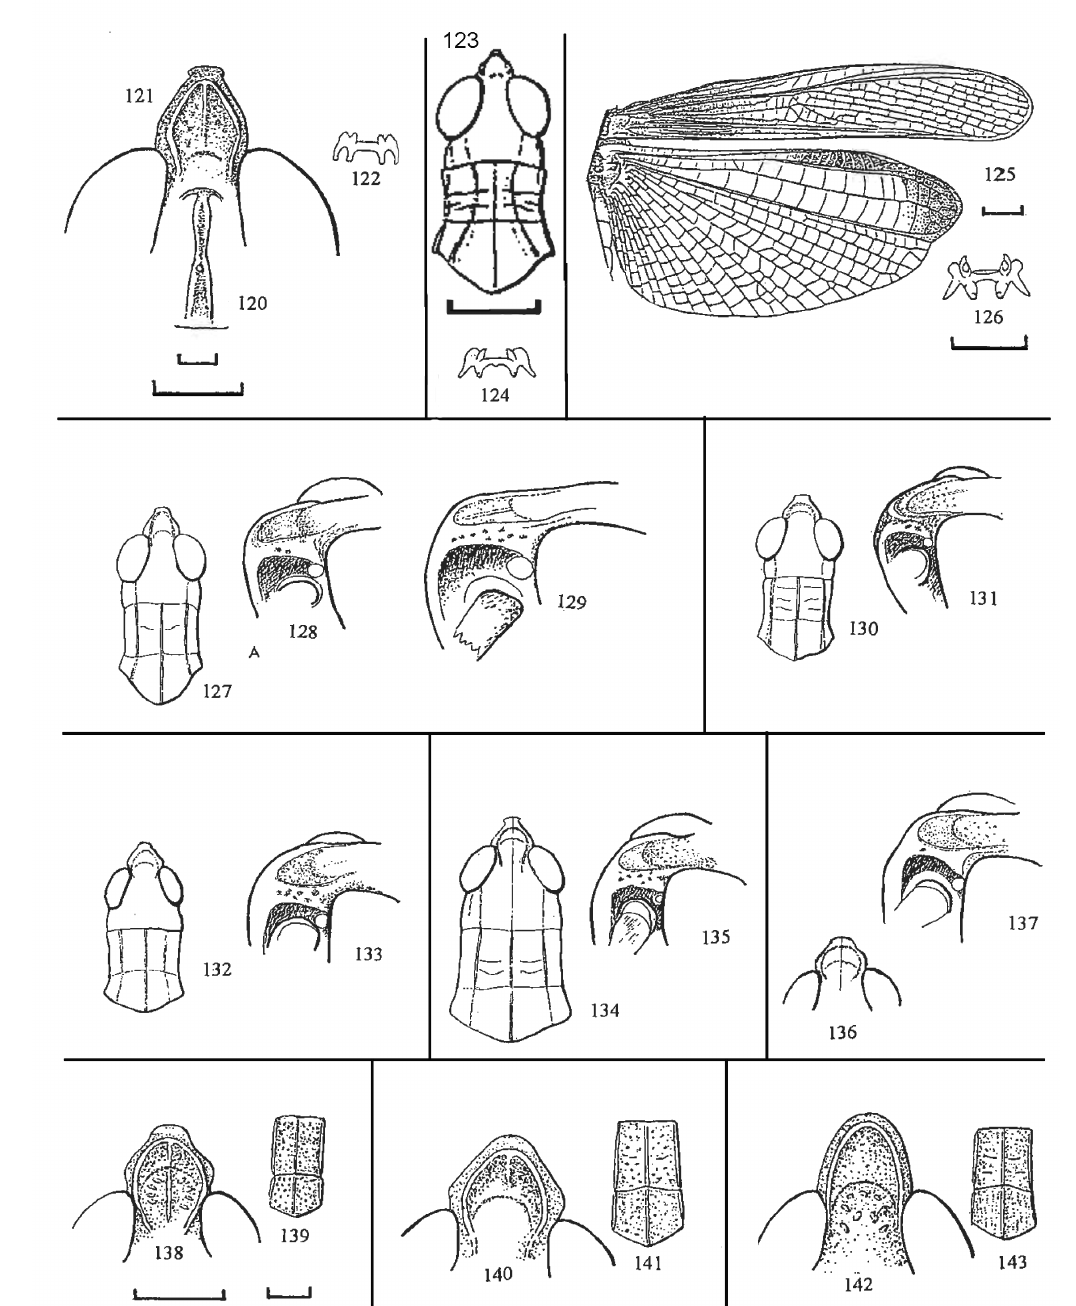
Figs 120–143. Tribe Gymnobothrini. Figs 120–122. Roduniella insipida male: 120. Frontal ridge; 121. Vertex from above; 122. Epiphal- lus. Figs 123, 124. Chirista compta male: 123. Head and pronotum from above; 124. Epiphallus (after Dirsh 1965). Figs 125, 126. Comacris semicarinatus male: 125. Fore and hindwings, note hind wing speculum; 126. Epiphallus. Figs 127–143 . Coryphosima spp: 127–129. C. stenoptera : 127. Head and pronotum male from above; 128. Oblique view of vertex and weak foveolar pits; 129. Oblique view of vertex and stronger foveolar pits; 130–131. C. brevicornis : 130. Head and pronotum male from above; 131. Oblique view of ver- tex. 132–133. C. stenoptera vicina : 132. Head and pronotum male from above; 133. Oblique view of vertex. Note: now a synonym of C. stenoptera stenoptera . 134–135 . C. bintumana : 134. Head and pronotum of male from above; 135. Oblique view of vertex. 136–137. C. maliensis : 136. Male vertex from above; 137. Oblique view of vertex. 138–139. C. cytidonotus : 138. Male vertex from above; 139. Prono- tal disc. 140–141. C. vumbaensis: 140. Male vertex from above; 141. Pronotal disc. 142–143. C. abyssinica: 142. Male vertex from above; 143. Pronotal disc. All scale lines represent 1 mm: that under Fig. 126 applies to Figs 122, 124 and 126; that under Fig. 125 applies to Fig. 120 (lower fig.) and Fig. 125; that under Fig. 138 applies to Figs 121, 128, 129, 131, 133, 135, 137, 138, 140, 142; that under Fig. 139 applies to Figs 127, 130, 132, 134, 136, 139, 141 and 143. That under Fig. 123 applies to Fig. 123